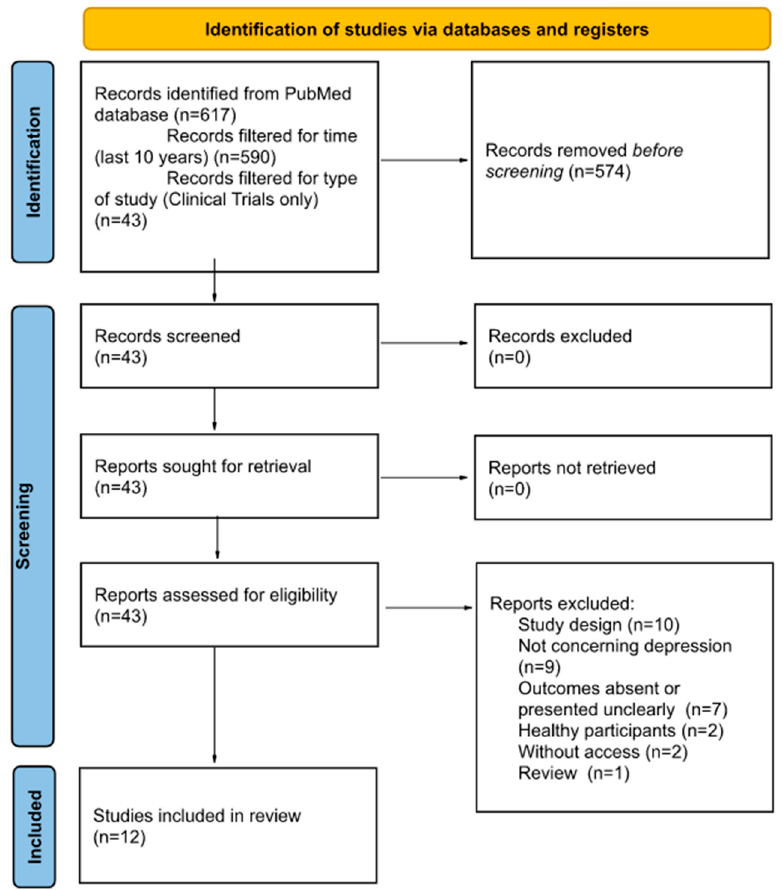
Figure 1. Flowchart presenting article selection